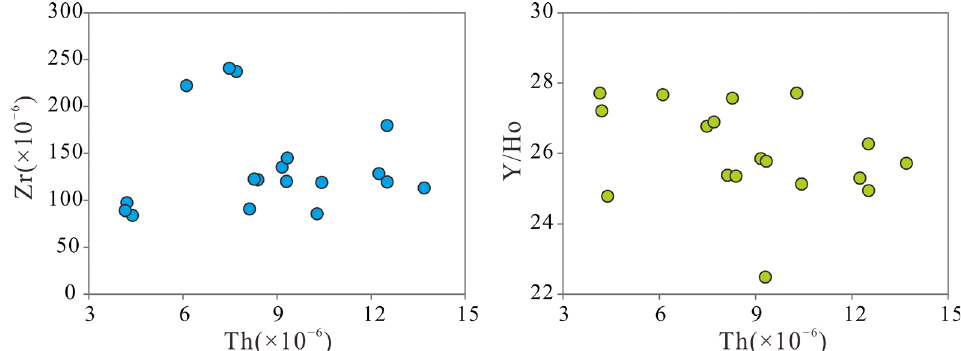
Figure 8. Diagrams of Th–Zr and Th–Y/Ho relationships among samples of the Lulehe Formation and Xiaganchaigou Formation.